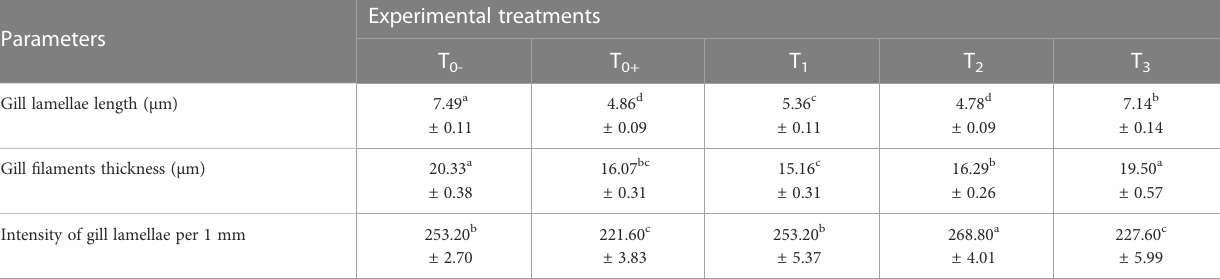
TABLE 3 Histometric properties of the hybrid red tilapia gills fed different ratios of corn oil: Aquafat-O ® and exposed to cold stress. Experimental Parameters